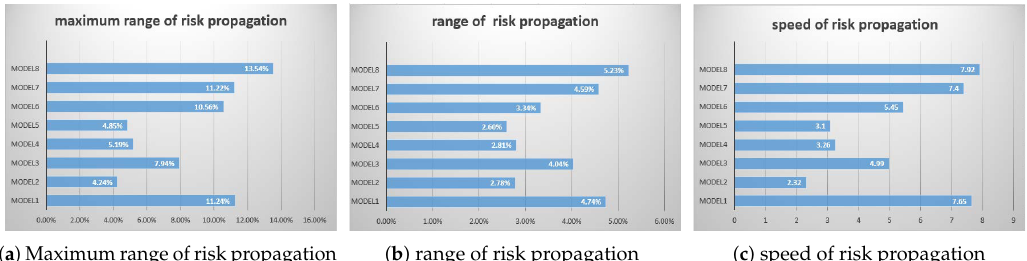
Figure 6. Comparison of risk propagation in models